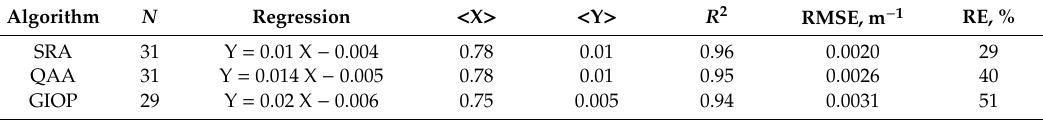
Table 6. The statistical parameters of the regression bbp(555) (Y) vs. c(530) (X) with different algorithms.